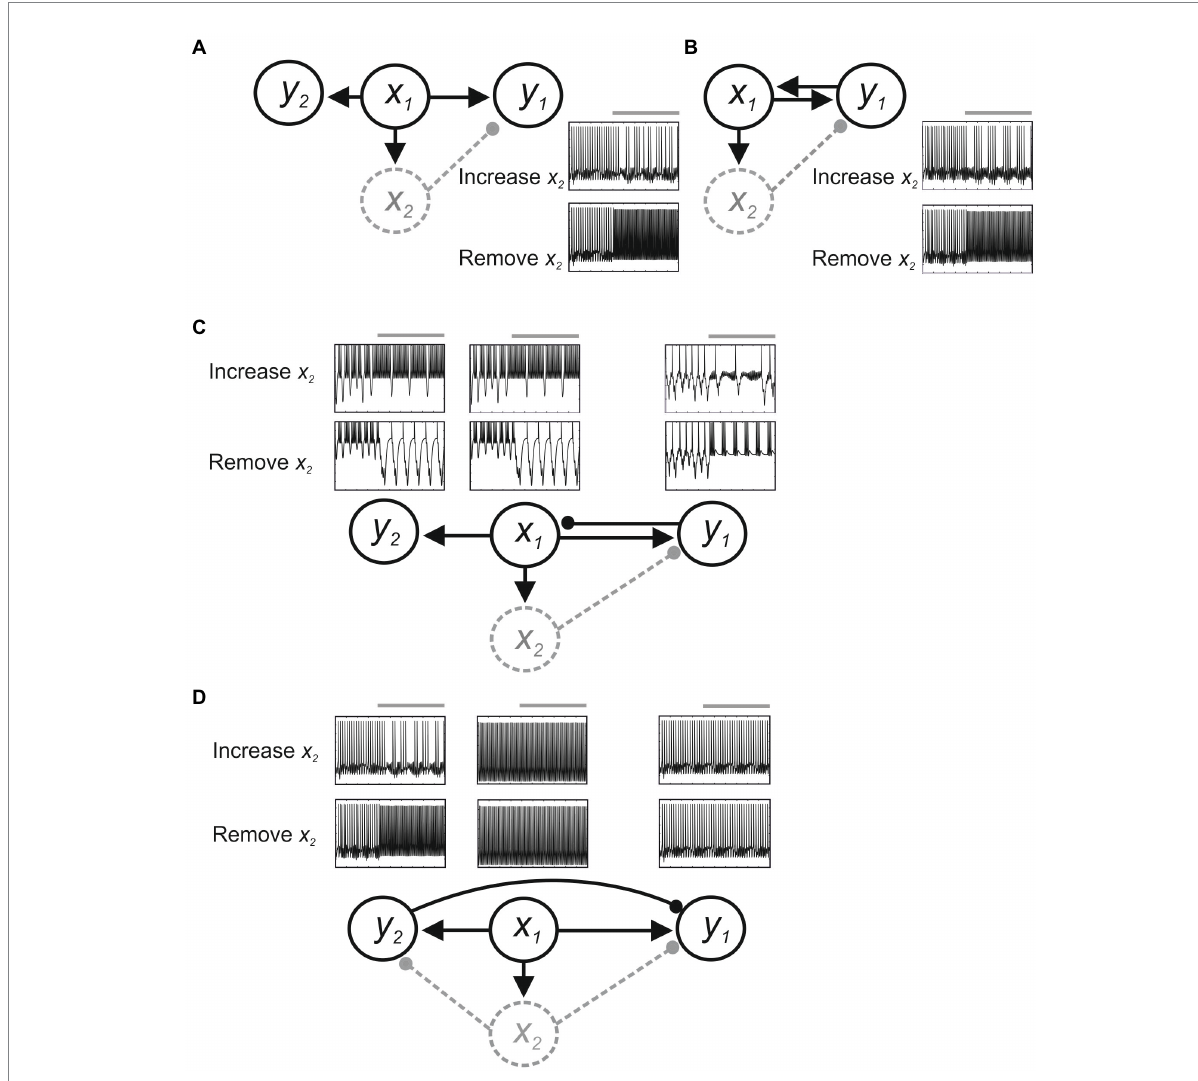
FIGURE 3 Feedback effects in a simple model. Neurons are modeled using Hodgkin-Huxley kinetics, and inhibitory (filled circle) and excitatory synapses (arrow) are modeled using alpha functions. The circuit is driven by a constant excitatory input to x 1 . (A) With only feedforward connections, positive and negative manipulations of x 2 decrease or increase y 1 activity. (B) Feedback excitation from y 1 to x 1 causes oscillation of y 1 activity when